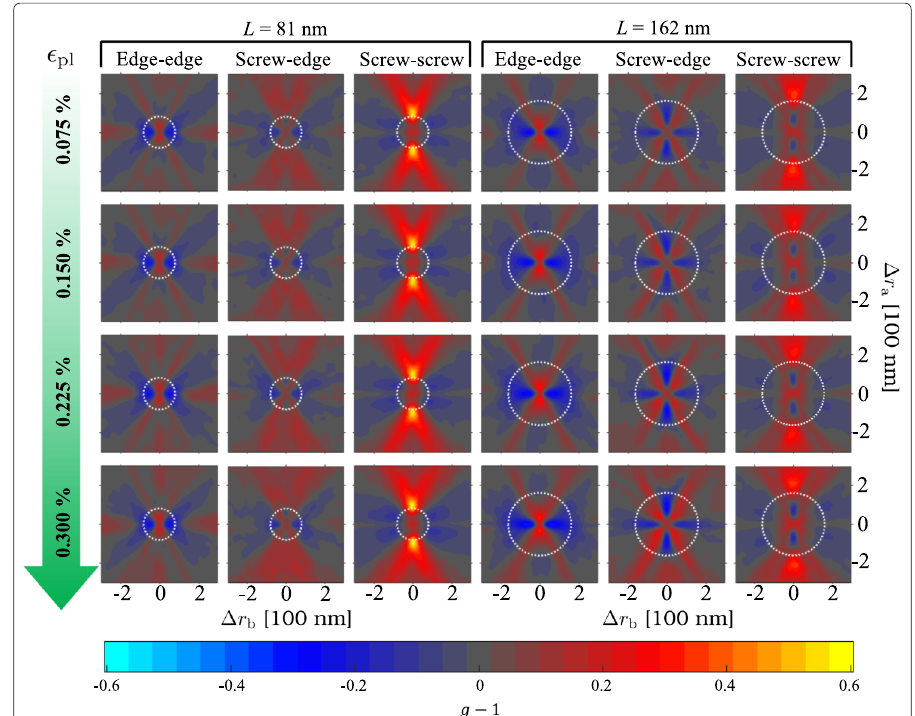
Fig. 5 Dependence of the correlation tensor on the plastic strain (a surrogate for the dislocation density). This dependence (or rather lack thereof) is shown for two convolution lengths, 81 and 162 nm. The white dotted circle has radius equal to the convolution length L . Each component of the correlation tensor is shown for both convolution lengths. Plastic strain increases with descending row, with strain steps at every 0.075%